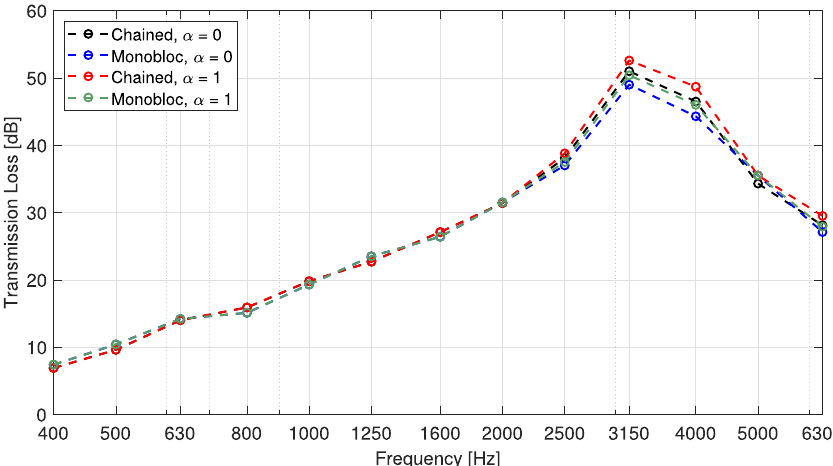
Figure 11. Transmission loss due to the association of one rigid expansion chamber and one fi lled with absorbing